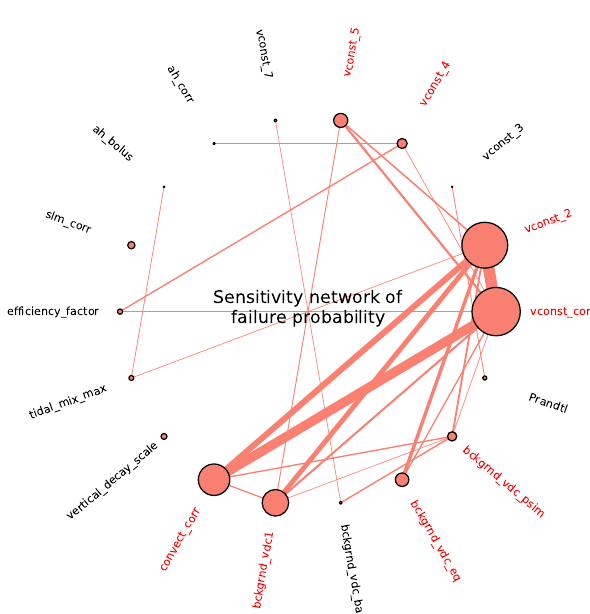
Fig. 10. Sensitivity of the probability of simulation failure to climate model parameters is shown using a network graph. Node size and connector thickness are proportional to sensitivity contributions from individual parameters and pairs of parameters, respectively. The eight parameters labeled in red are the main causes of simulation failures.